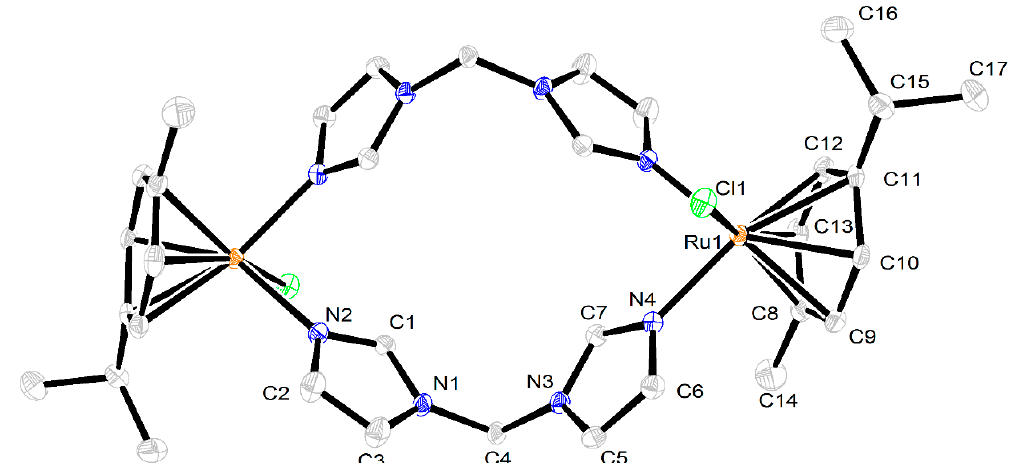
Figure 4. X-ray molecular structure of complex 2 . Thermal ellipsoids are drawn at a 50% probability level. Hydrogen atoms, solvate methanol molecules, and Cl − anions are omitted for clarity.